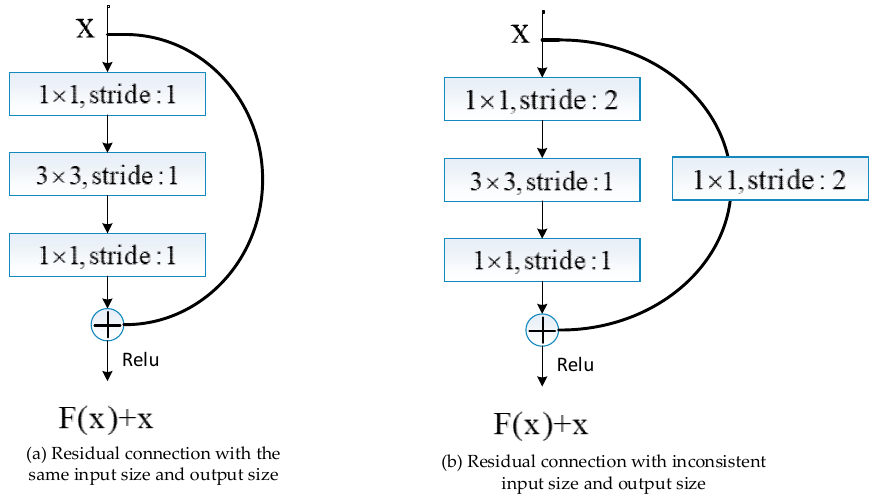
Figure 2. Schematic diagram of subsampled block structure in the hourglass structure.